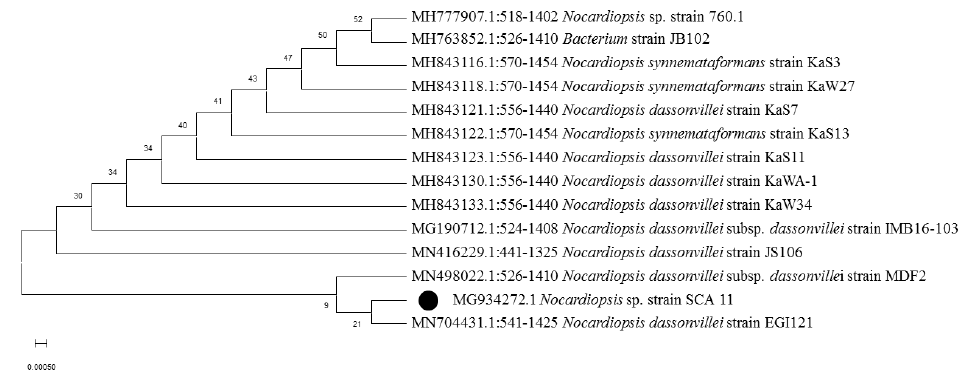
Figure 3. Phylogenetic analysis of isolate Nocardiopsis sp. strain SCA11. Neighbor-joining phylogenetic tree showing evolutionary relationship of selected isolate based on 16S r-RNA sequence alignments. Bootstrap values at the nodes indicate collated values based on 1000 resampled datasets. Bar indicates 0.0005 substitutions per nucleotide position.